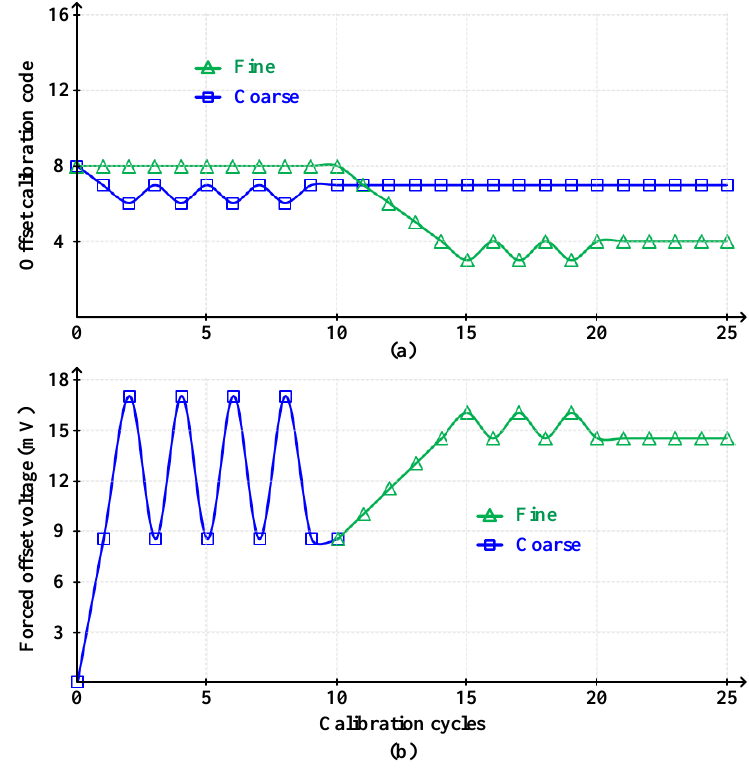
Figure 18. ( a ) The coarse-fine offset calibration convergence for window detecting comparator, and ( b )